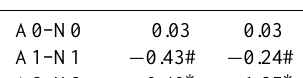
Table 4. Differences of global-mean radiative forcing (in Wm − 2 ) between simulations at the surface and top of atmosphere (TOA) under both clear-sky and all-sky conditions. Statistical significance under a two tailed test on the monthly values is indicated with the symbols “ ∗ ” and “#” for reaching the 95% and 80% confidence lev- els, respectively. Clear sky All sky